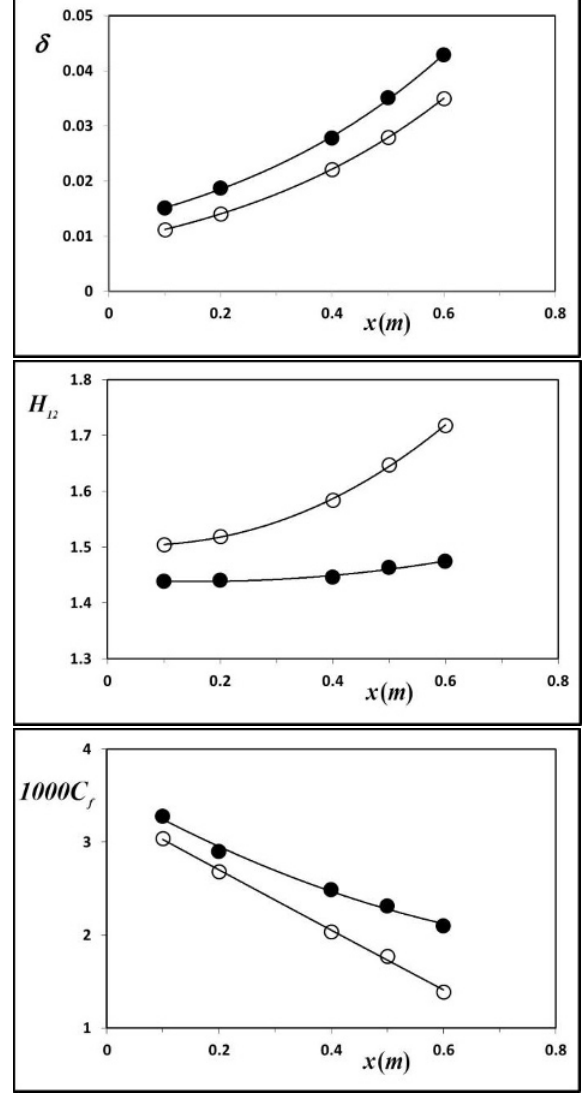
Fig. 6. Important characteristics of turbulent boundary layers developing in natural FST (empty symbols) and in grid FST (black